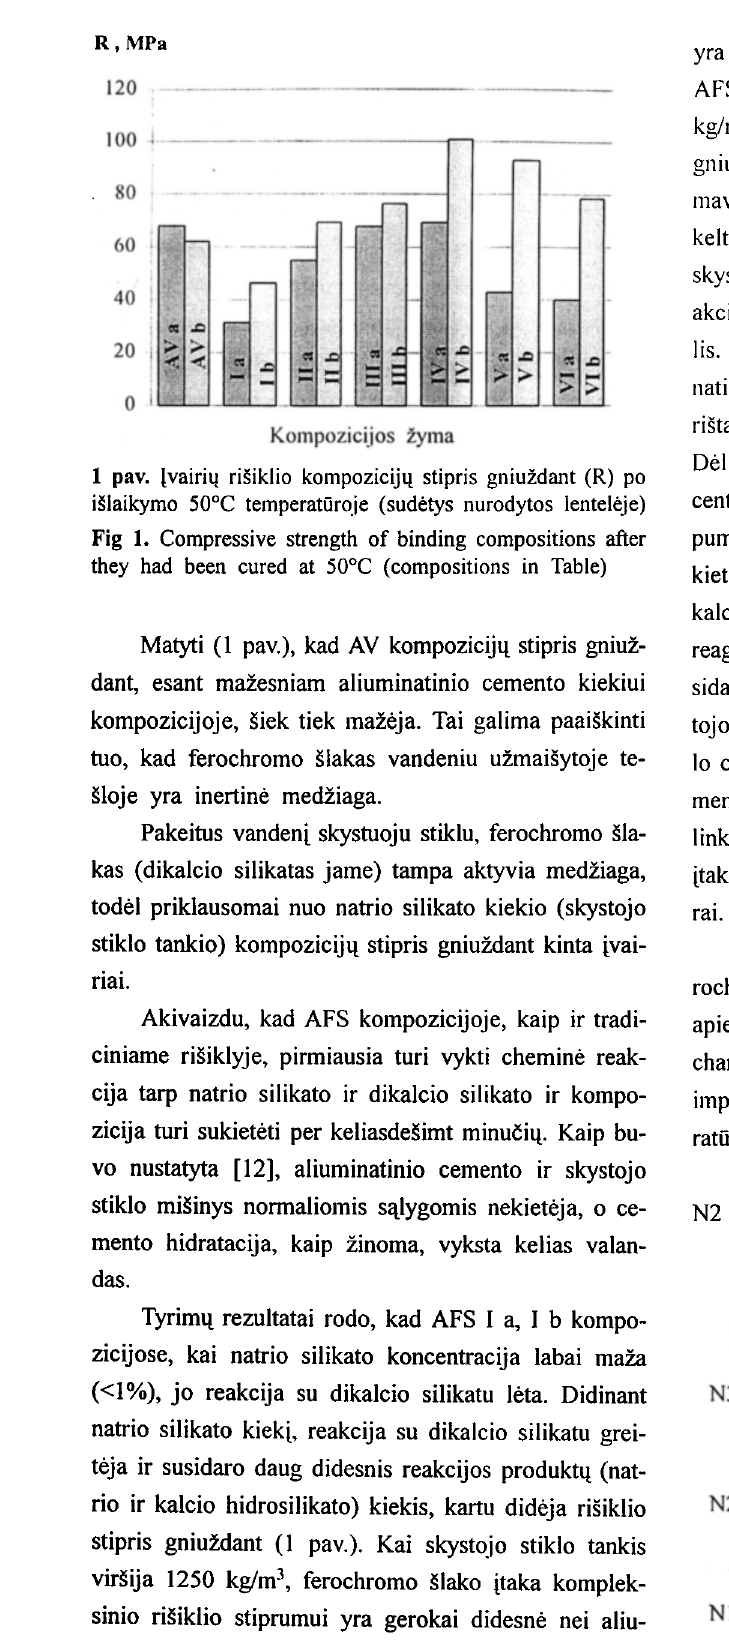
chaniniq charakteristiJ...l! (stiprio gniuZdant, ultragarso impulso greicio, deformacijq) tyrimai didinant tempe ratiirlt.